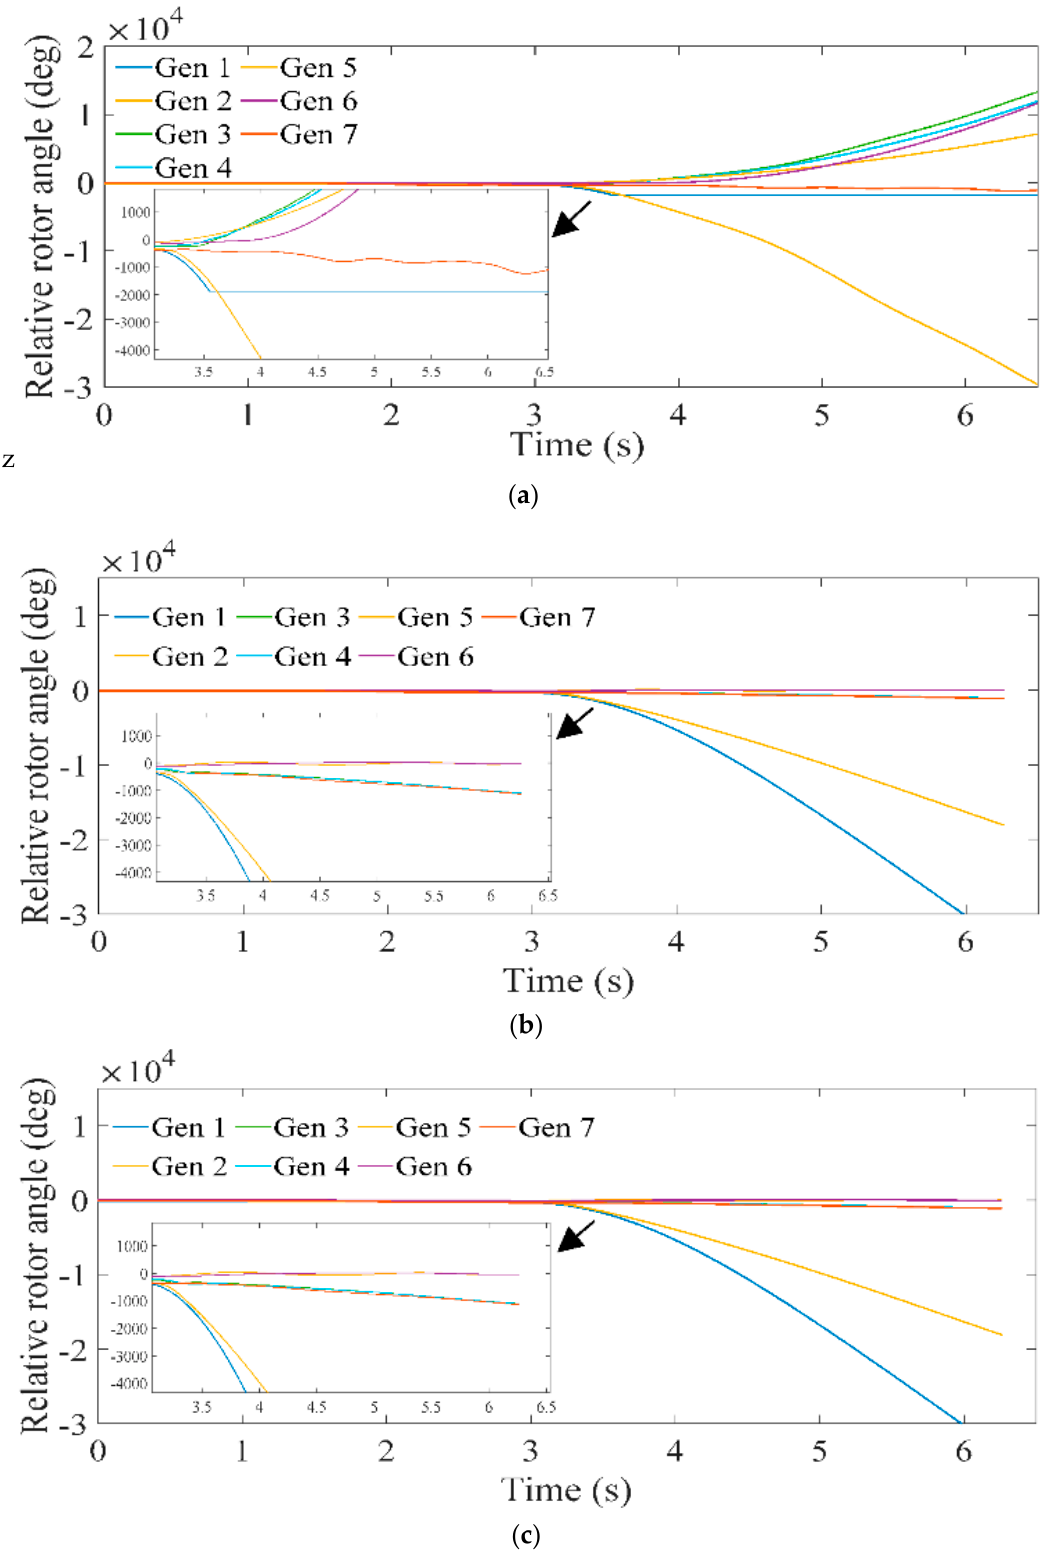
Figure 9. The RRA of a set of generators in Contingency 1 : ( a ) Case 1, ( b ) Case 2, and ( c ) Case 3.